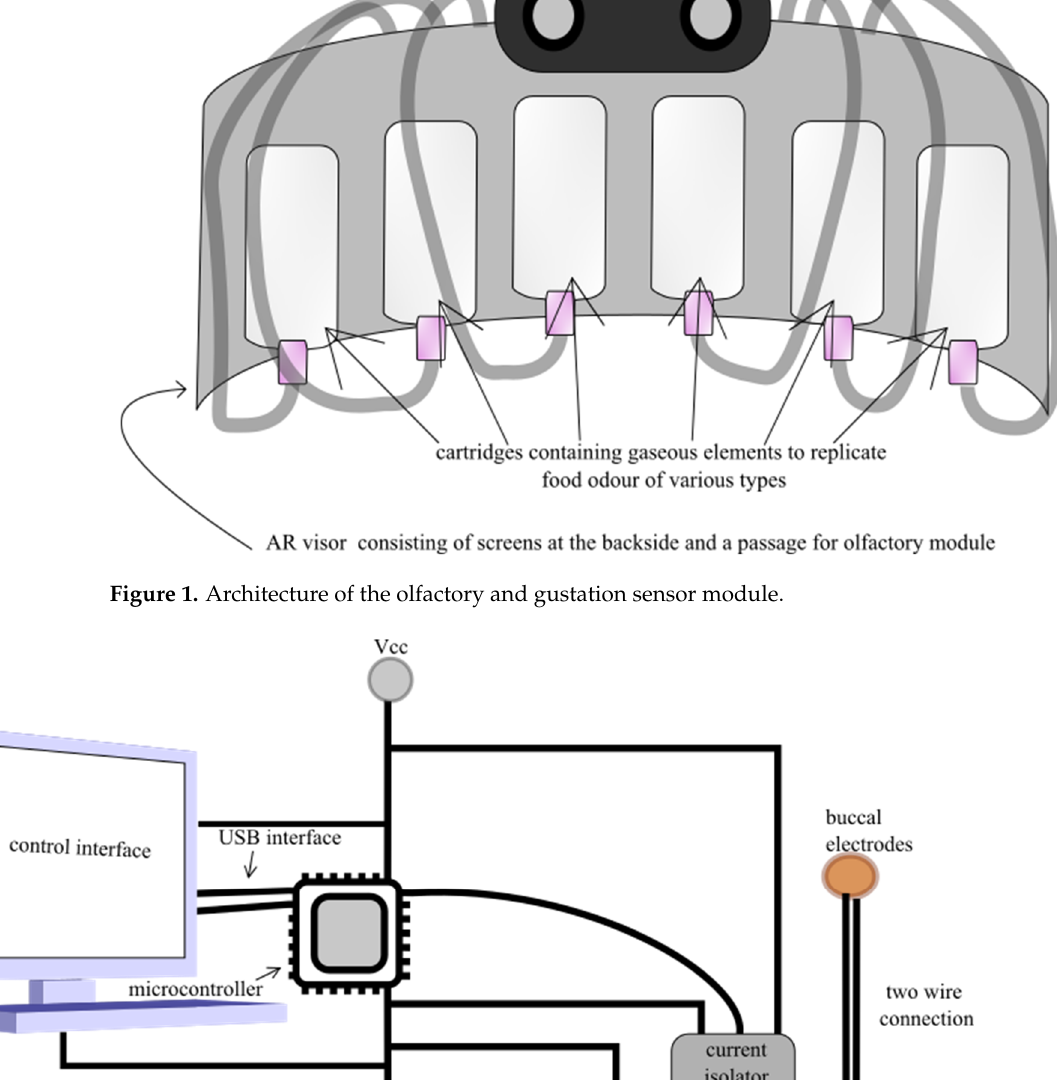
Figure 3. The general block diagram of the taste+ system. A prototype tongue-mounted module for post-current release taste modulation was developed in 2012 and presented at the 16th international wearable computers symposium as a prototype that would take the form of a digital lollipop in its later stages of development [12,13]. Its taste-modulation output characteristics are depicted in Figure 4.